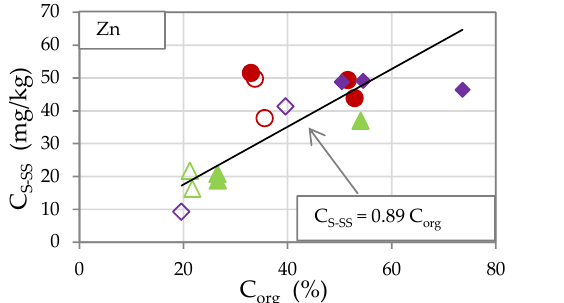
Figure 13. Relationship of the heavy metal concentration of the suspended solids (C S-SS ) and the organic content of the leachate (C org ).